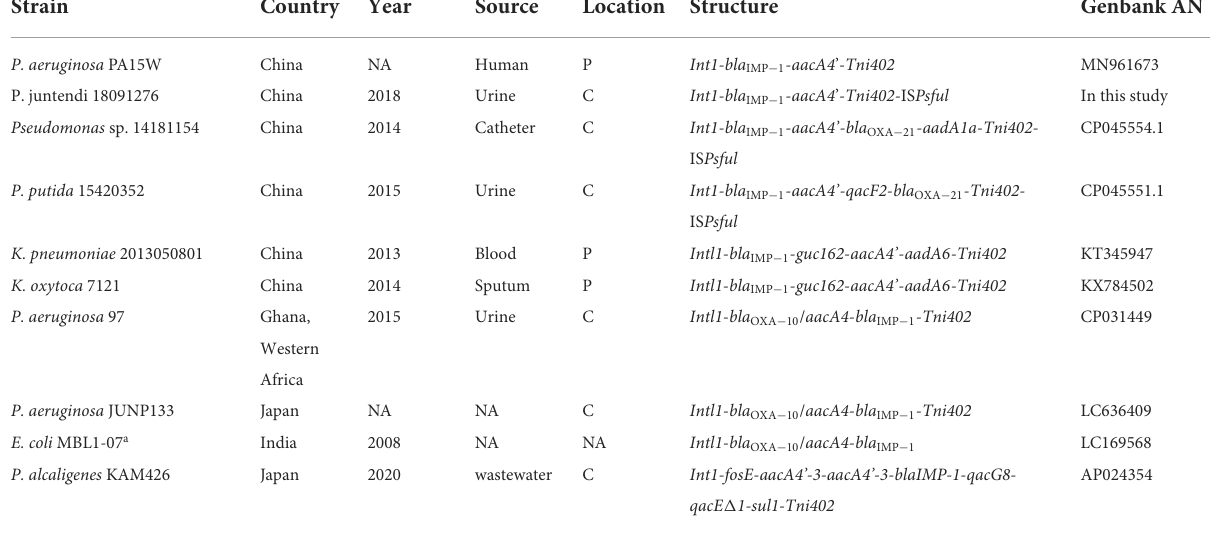
TABLE 4 Genetic contexts of In 1886 . Strain